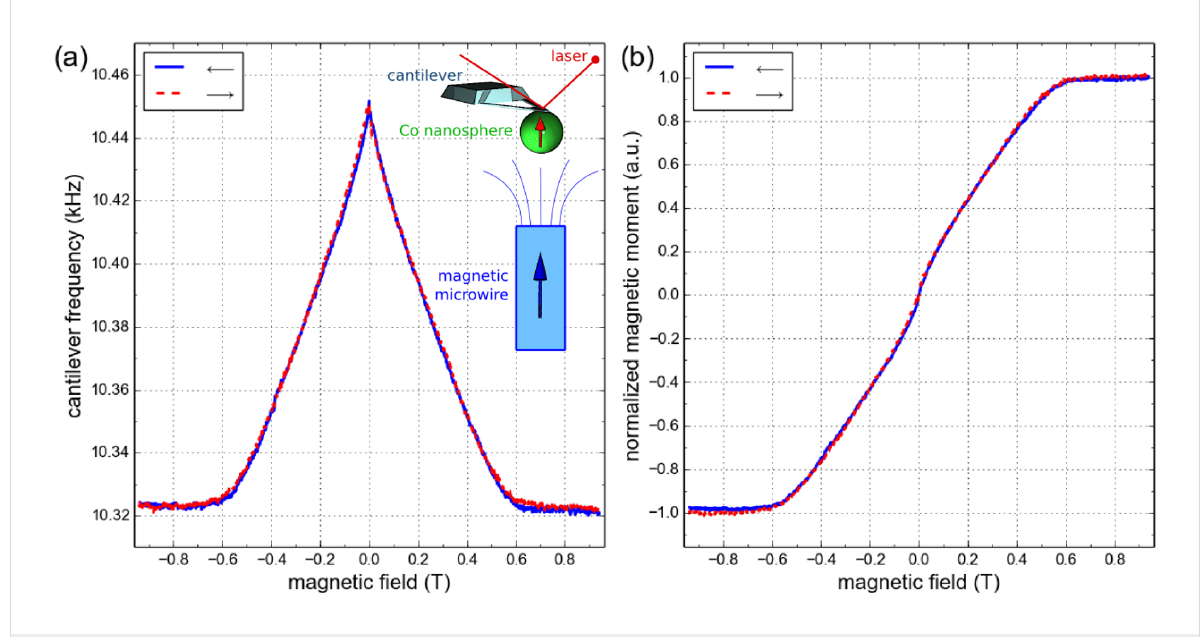
Figure 6: Cantilever magnetometry of a 500 nm diameter cobalt nanosphere. (a) Raw data of the cantilever frequency vs applied magnetic field. Inset: Sketch of the cantilever magnetometry setup. (b) Extracted magnetization curve.